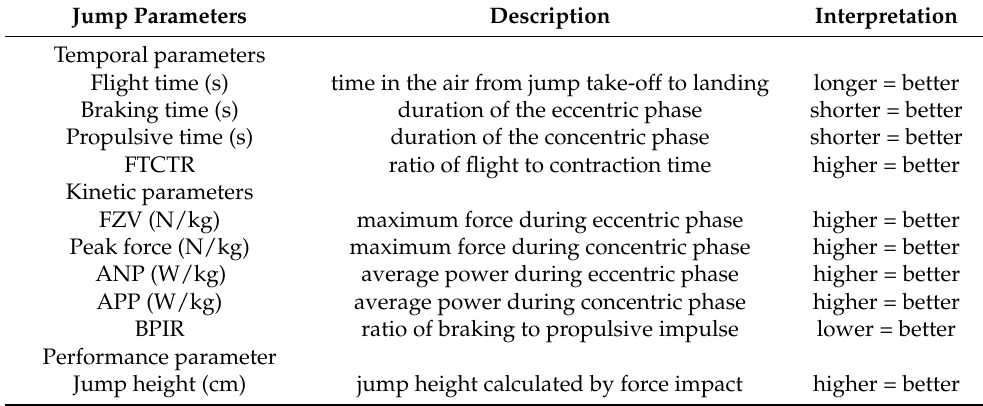
Table 1. Measured jump parameters by force plate. Jump Parameters Description Interpretation Temporal parameters Flight time (s) time in the air from jump take-off to landing Braking time (s)